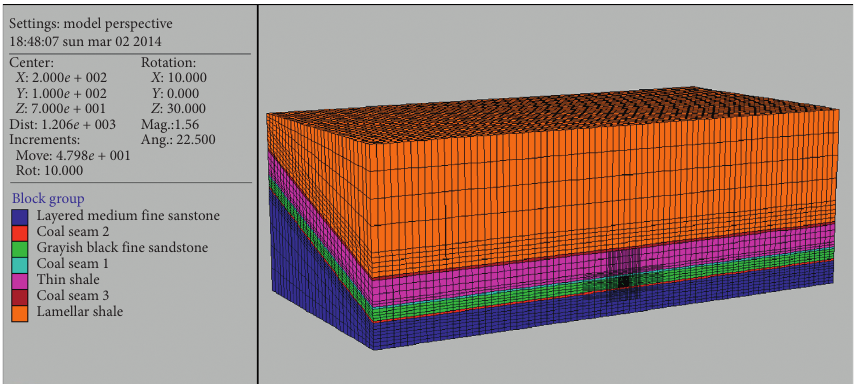
Figure 6: The model mesh